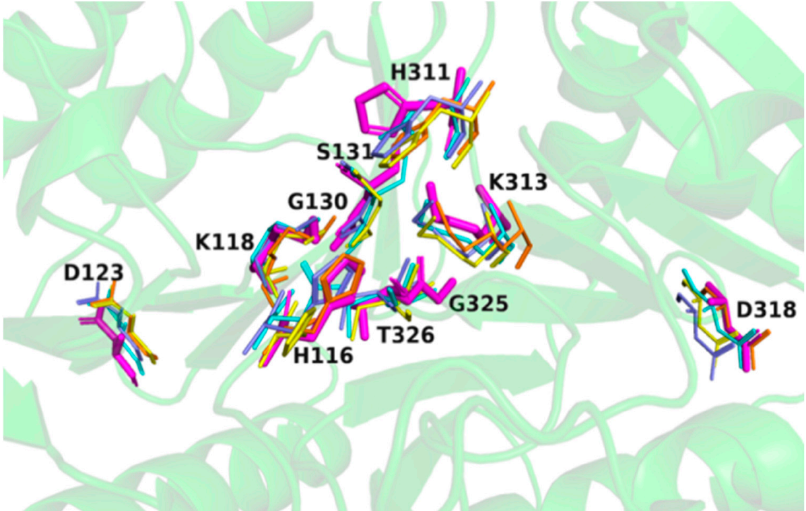
Figure 6. Two classical HxKxxxxD (HKD) motifs were found in SpPLD and showed high structural consistence with several PLDs within the same family. SpPLD (magentas, PDB ID: 7E0M), Strepto- myces sp. PMF PLD (yellow, PDB ID: 1F0I), SaPLD (light blue, PDB ID: 2ZE4), Zuc (orange, PDB ID: 4GEL), NucT(cyans, PDB ID: